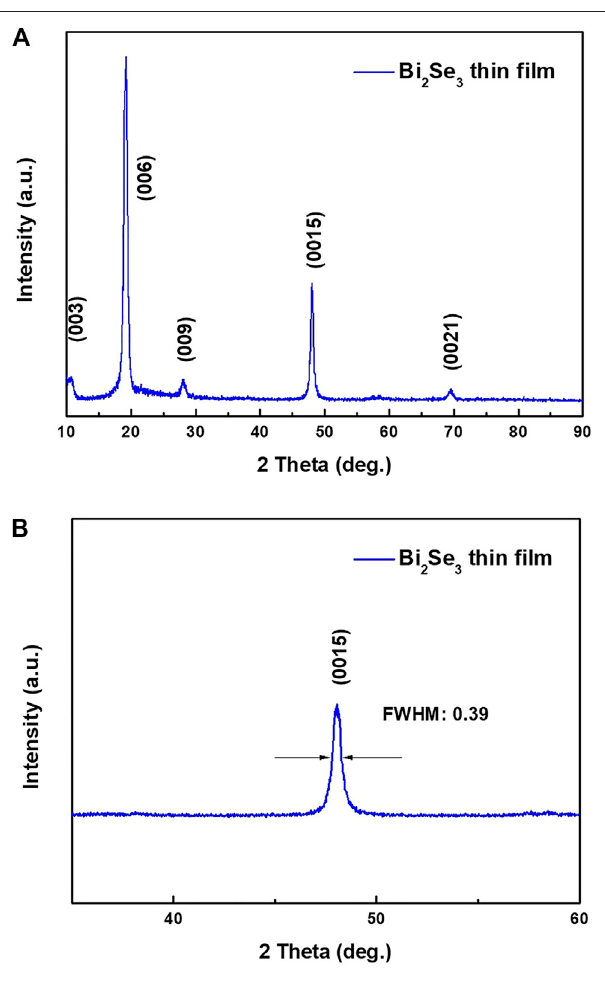
FIGURE2 | X-ray photoelectron spectra of Bi 2 Se 3 thin fi lm, (A) Bi-4f, (B)